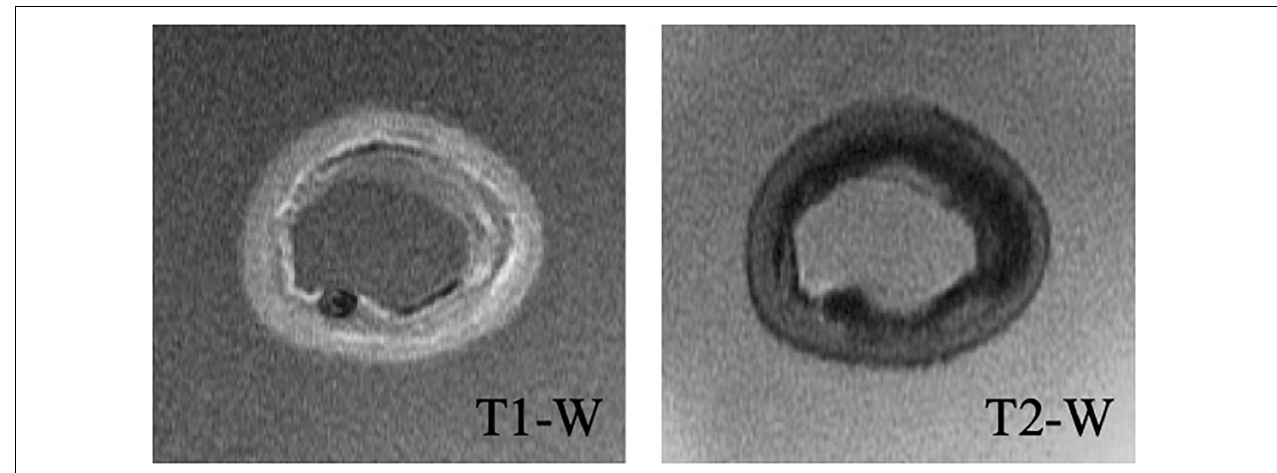
FIGURE 2 | Representative T1- and T2-weighted MRI images of cross-section #9. TABLE 2 | iFEM predicted Yeoh constants for fibrous intima and wall, and their respective NMSE values. Fibrous intima (kPa) Wall (kPa) NMSE